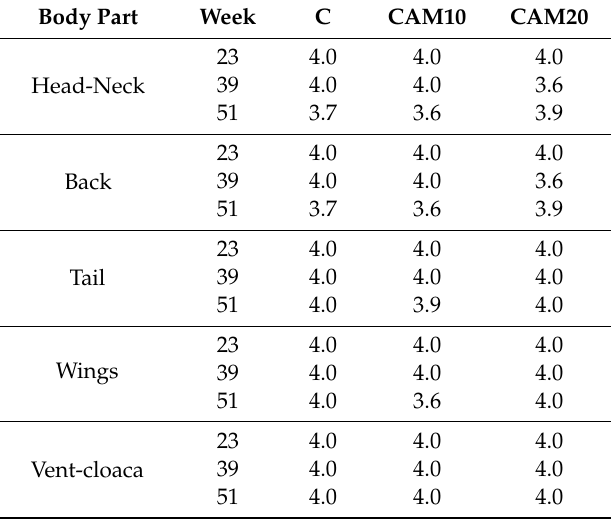
Figure 3. Box-and-whisker plots including individual measurements of egg weight (g). Effect of hen age (weeks) and different camelina cake level in the diet (Control diet—C, camelina diets—CAM10 and CAM20). The horizontal boxes refer to the medium values for Hy-Line ® brown standard. Table 5. Plumage condition in the five areas considered using Welfare Quality ® scoring system. Control diet (C) and camelina diets (CAM10 and